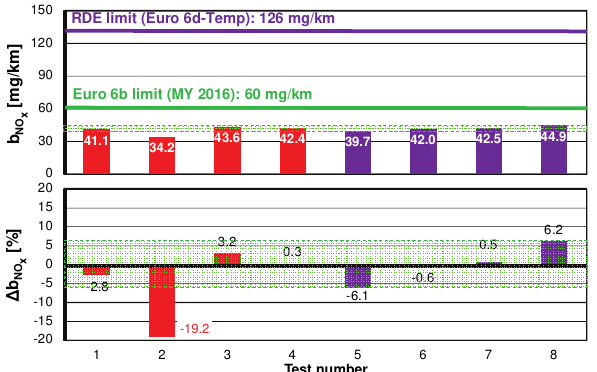
Fig. 10. Road emission of nitrogen oxides and relative error for all drives